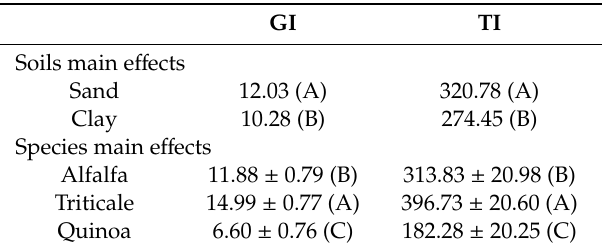
Table 4. Soil and species main e ff ects on GI and TI of alfalfa, triticale, and quinoa. Abbreviations: GI, germination index; TI, Timson’s index.